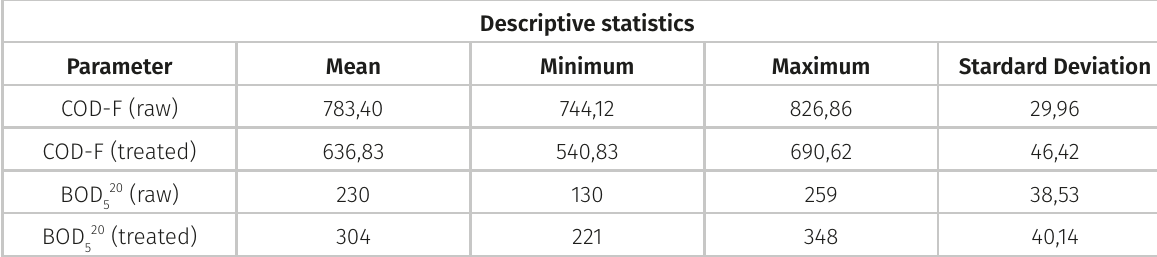
Table X . Descriptive statistics for COD-F and BOD 520 data for raw leachate and post-treatment. Descriptive